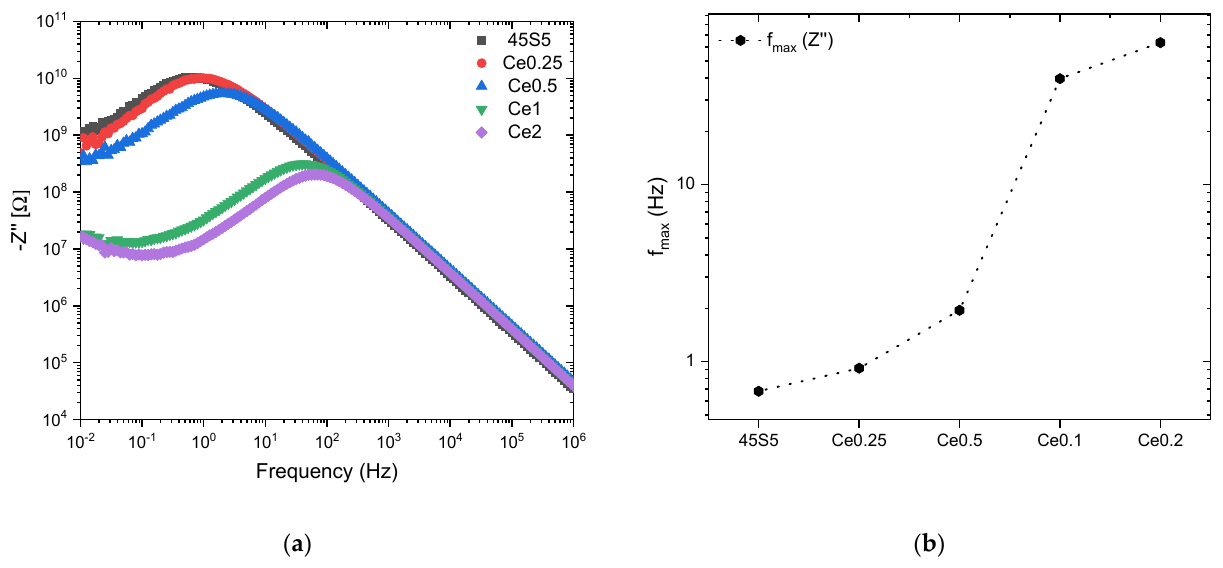
Figure 8. ( a ) Z (cid:48)(cid:48) versus frequency at 37 ◦ C; ( b ) frequency of the Z (cid:48)(cid:48) maximum as a function of the Ce content.